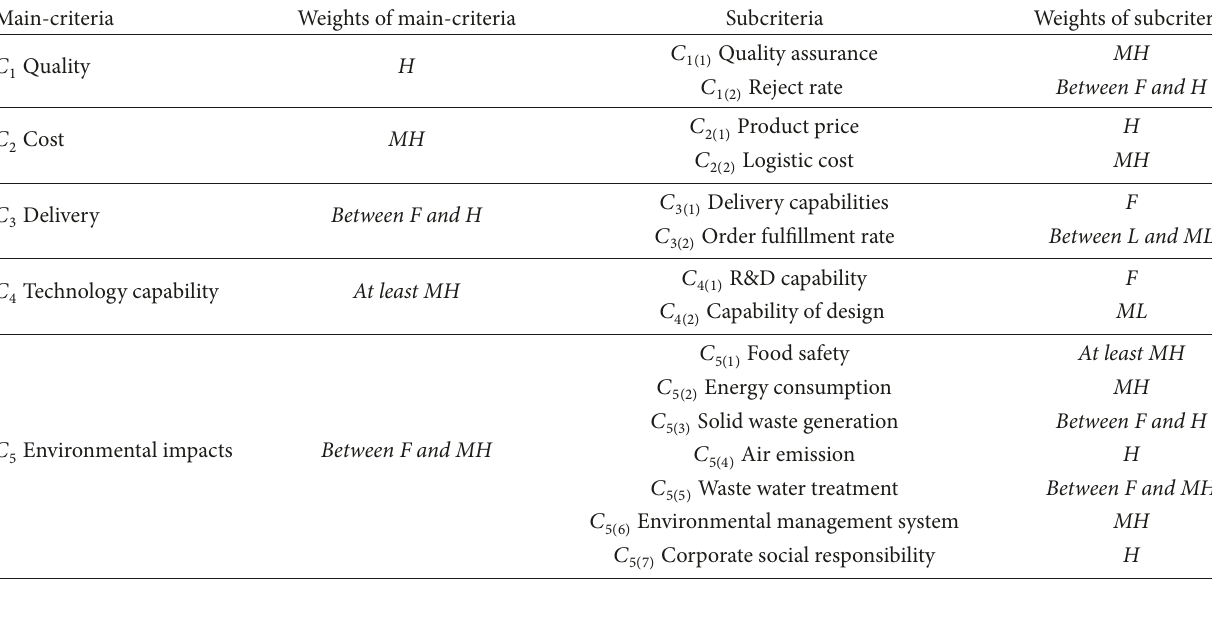
Table 1: The description of the subcriteria and five main-criteria [1] and their weight